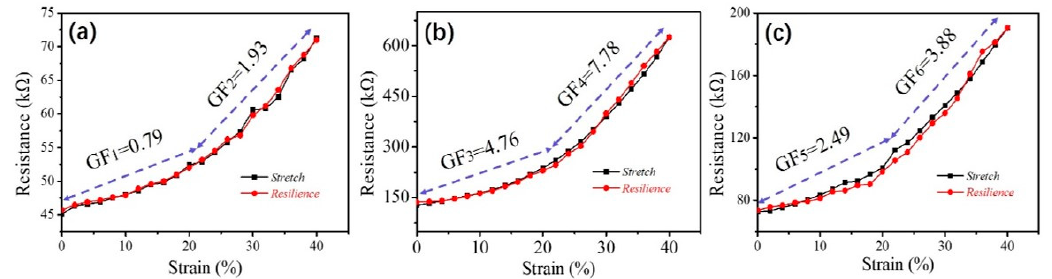
Figure 7. Cyclic test of relative resistance change as strain increases up to 40%, ( a ) origin sample; ( b ) temporarily stretched sample (strain of 40%); ( c ) recovered sample from the fixed strain of 40%.